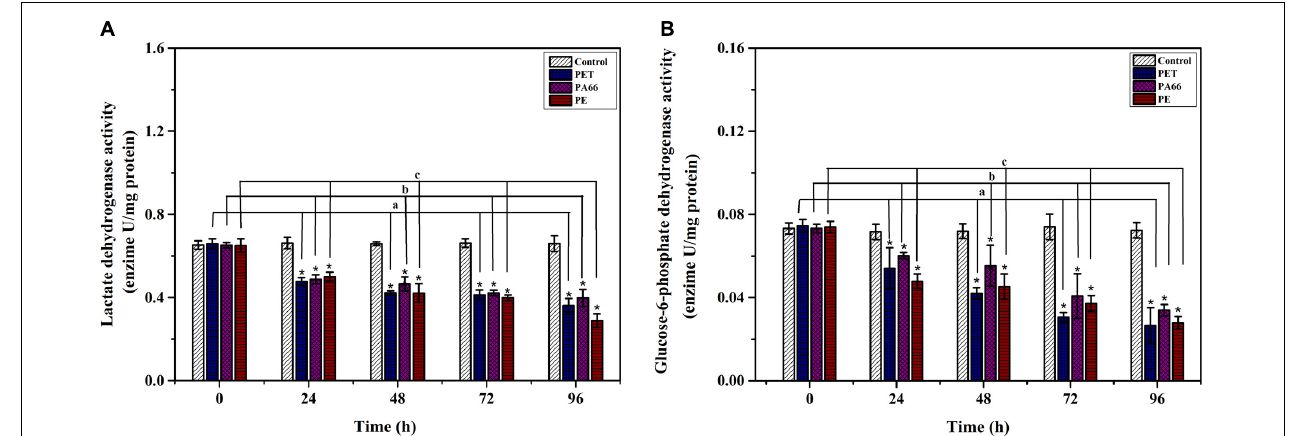
FIGURE 6 | Energy metabolism enzyme analysis. LDH activity (A) and G6PDH activity (B) in the coral Acropora pruinosa after different MPs (PET, PA66, and PE 50 mg/L, respectively) exposure experiment. Histogram data represent means and error bars represent standard deviations ( N > 3). Asterisk (*) represent a significant difference from normal (* p <